Question: Briefly state, in one sentence, what is plotted here.
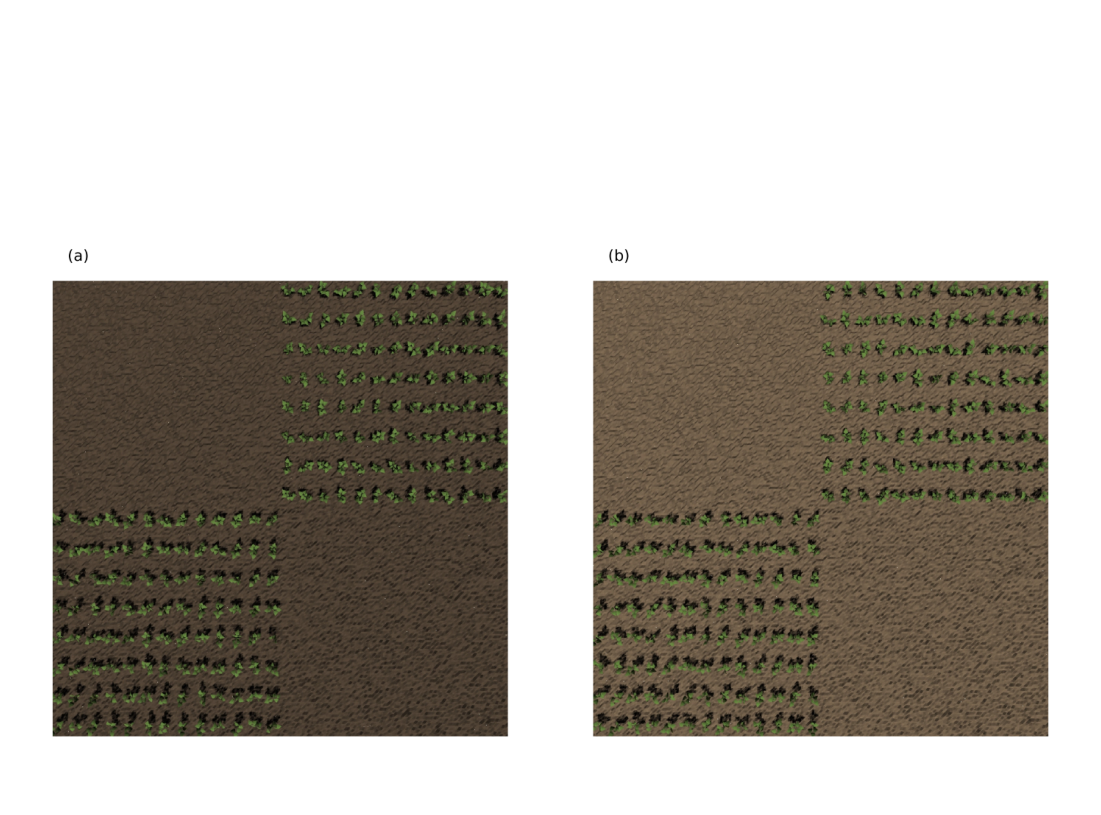
Answer: Synthetic soil-plant images based on soil properties of (a) Terra Preta soil: Clay: 8 %, Silt: 7 %, Sand: 85 %, Soil organic matter: 120 g/kg, Total iron content: 80000 mg/kg, Organic carbon content: 38 g/kg, Cation exchange capacity: 123 cmol(+)/kg, pH measured from water: 4.7; (b) soil near Davis, CA, USA: Clay: 33 %, Silt: 47 %, Sand: 20 %, Soil organic matter content: 30 g/k, Organic carbon content: 8 g/kg, Electrical conductivity 55 mS/m, pH measured from water: 6.8, Cation exchange capacity: 30 cmol(+)/kg). These scenes were illuminated by simulated sun light using the ASTM standard clear sky solar spectrum distribution with solar zenith angle of 20◦. A simulated Nikon B500 camera (Nikon, Minato City, Tokyo, Japan) was used for imaging, and the camera response spectra used is shown in Fig. 13b.